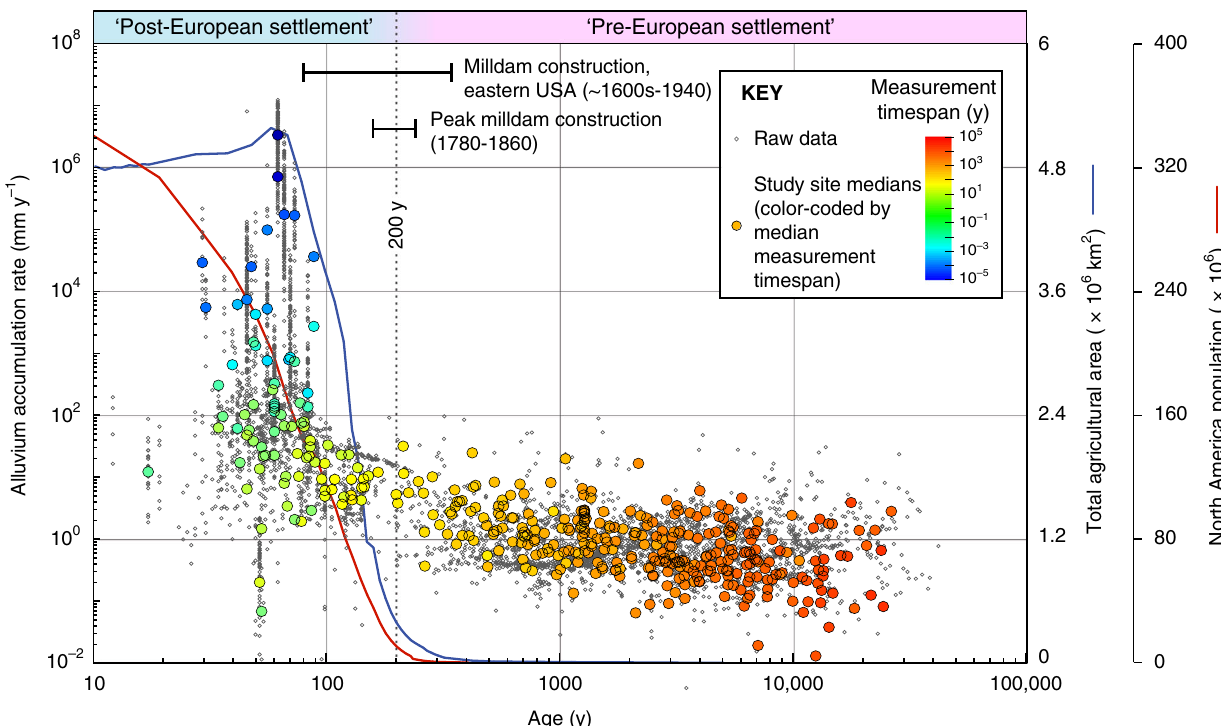
Fig. 2 North American alluvium accumulation rates versus age. Raw data are shown as gray circles (note logarithmic scales). Colored datapoints are the median rates and ages at each study site, with color-coding based on the timespan of measurement. Note the tendency for rates measured over short timespans to be faster (particularly apparent in rates aged <100 y), illustrating how rates are partially biased by timespan dependence (see text and Fig. 3a for details). Nevertheless, there is a stepwise increase in rates between the approximate pre- and post-settlement time periods ~200 y ago (~1820 CE). This increase coincides with a marked expansion in total agricultural land area in North America (blue line, data from ref. 23 ) and the onset of rapid population growth (red line, data from ref. 45 . USA population prior to 1790 includes only white Europeans 45 ). Agriculture and population increases are bracketed by an interval of intensive milldam construction in both Canada and USA (dates from refs. 5,24,25 ). The stepwise increase in accumulation rates ~200 y ago is not attributable solely to timespan dependence, and re fl ects an anthropogenic impact on alluvium